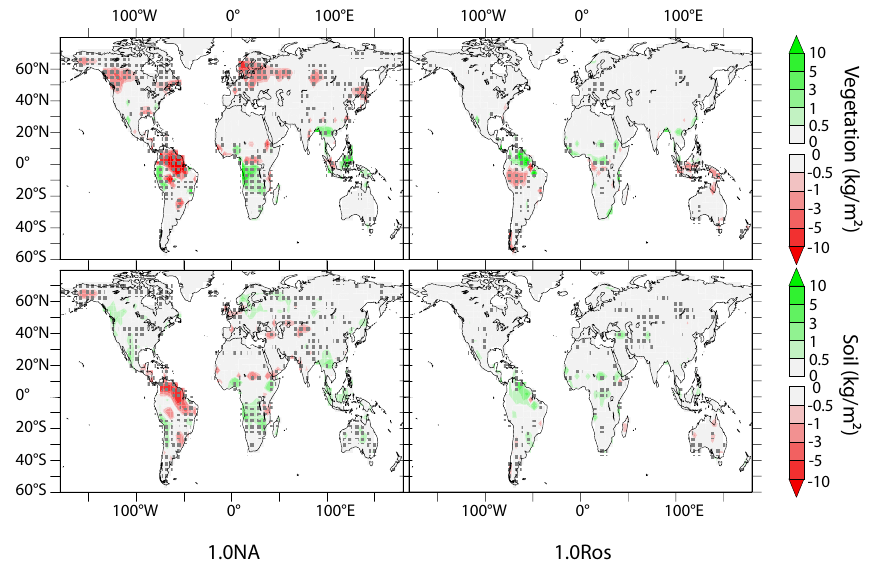
Fig. 6. Changes in the vegetation and soil (including litter) carbon (kgm − 2 ) by the end of the perturbation (decadal average) for the experiments 1.0NA (left) and 1.0Ros (middle). Stippled areas indicate where the ensemble mean anomaly is significantly different from zero at the 67% level (Student’s